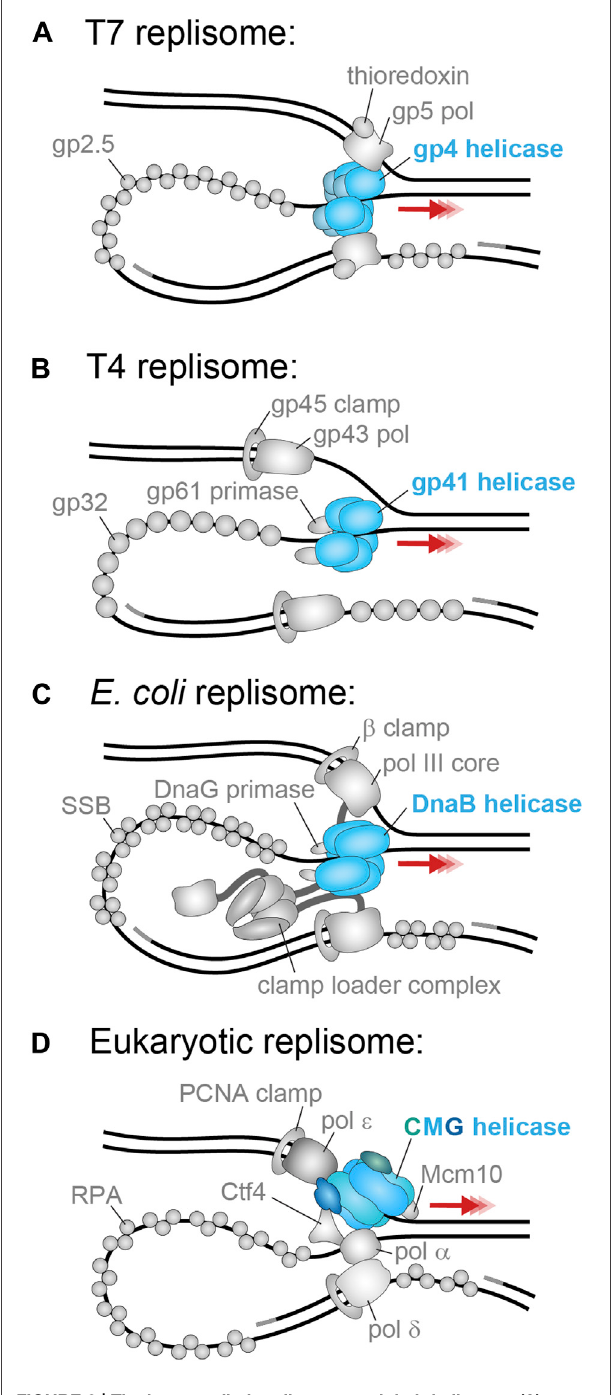
FIGURE 3 | leading- and lagging-strand arms of the clamp loader complex (Lewis et al., 2016). (D) The S. cerevisiae replicative helicase, CMG (Cdc45 in green; MCM2 – 7 in blue, GINS in dark blue), translocates in the 3 ′ – 5 ′ direction on the leading strand and contacts the leading strand polymerase Pol ε , as well as the primase Pol α , fi ring factor Mcm10, organizing factor Ctf1, and MTC accessory factor (omitted) (Lewis et al.,